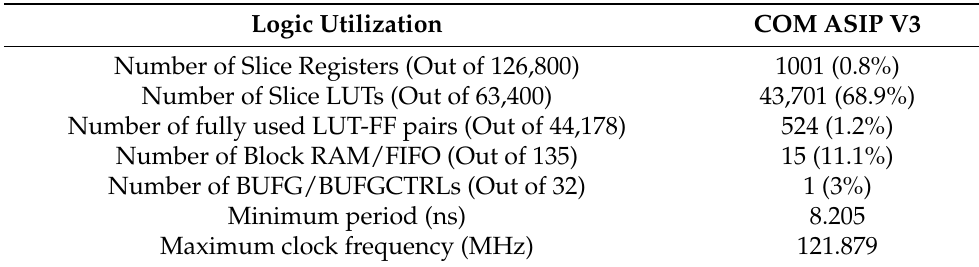
Table 5. Logic utilization from synthesis results for COM ASIP V3.